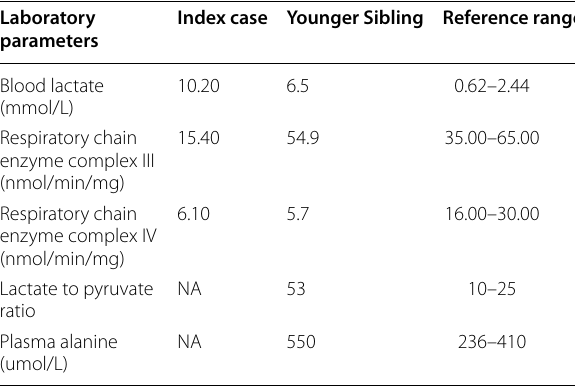
Summary of metabolic study performed in the described cases. NA not available